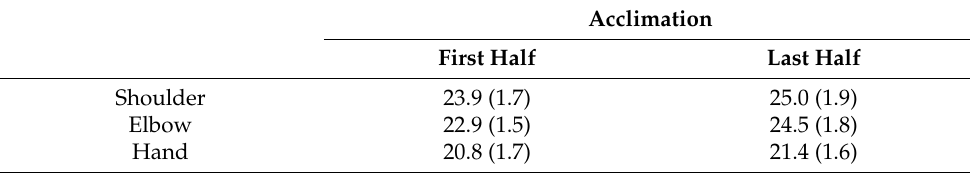
Table 4. Average (S.E.) minimum comfortable distance in centimeters, considering